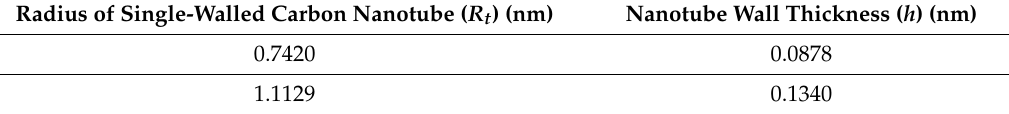
Table 2. The parameters used for modeling